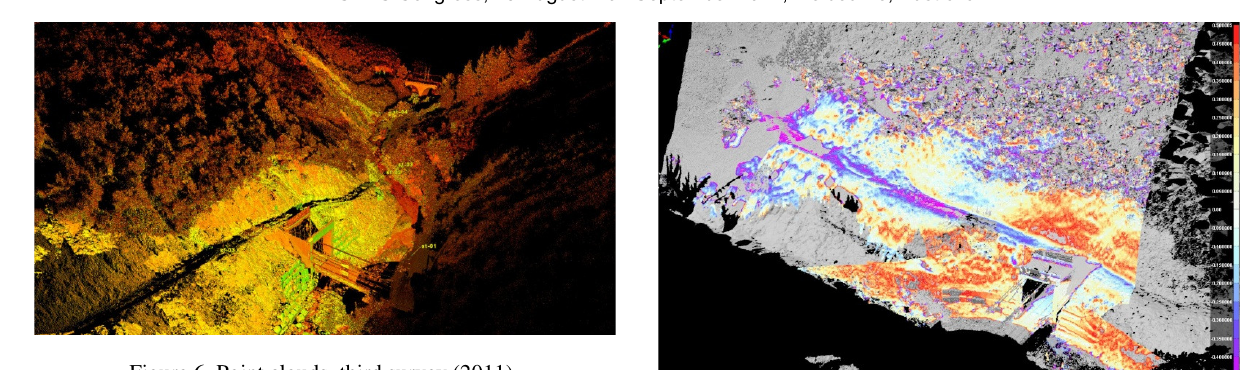
Figure 6. Point clouds , third survey